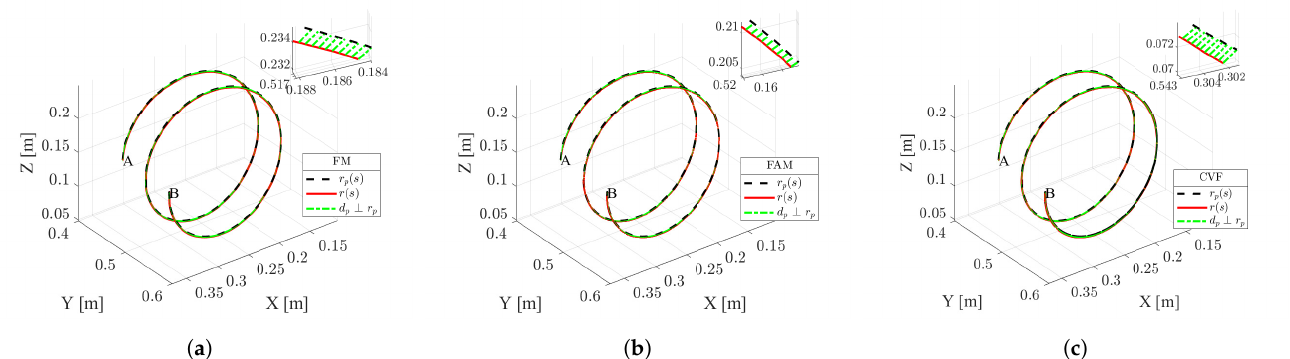
Figure 8. Helix path tracking. r p ( s ) -black dashed line, r ( s ) -red solid line, distance from each point of r ( s ) to r p ( s ) -green dotted line. ( a ) FM. ( b ) FAM. ( c ) CVF.